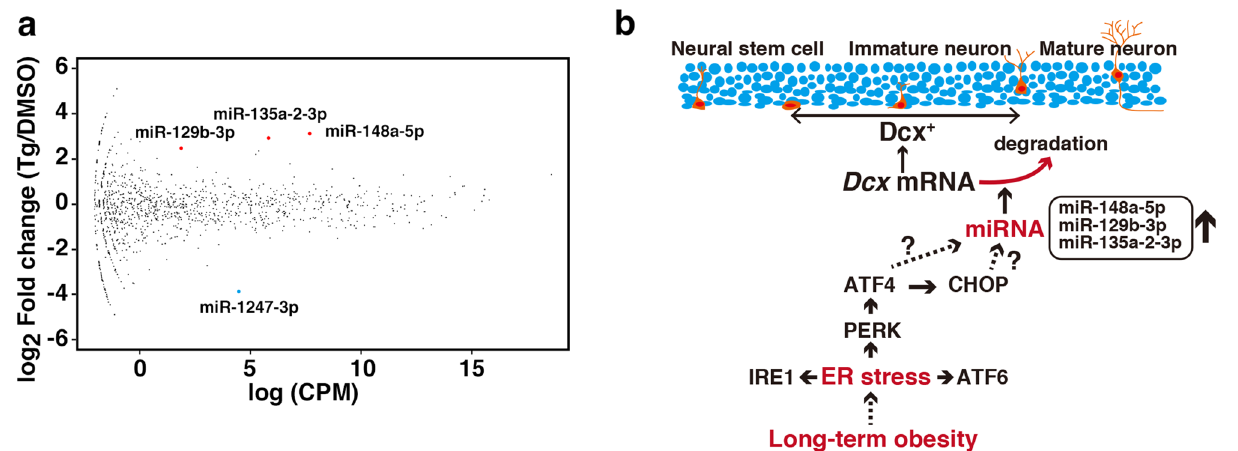
Figure 5. ER stress increased the miRNA expression in differentiating neurospheres. ( a ) Differential expression analysis of miRNAs in DMSO-treated cells (n = 3) and thapsigargin-treated cells (n = 3) was performed using edgeR. The y-axis indicates the expression ratio [log 2 (fold change)], and the x-axis indicates the average of expression [log (CPM)]. Solid red circle: upregulated miRNA; solid blue circle: downregulated miRNA. FDR < 0.05. ( b ) Model of the effect of long-term obesity on neural maturation during